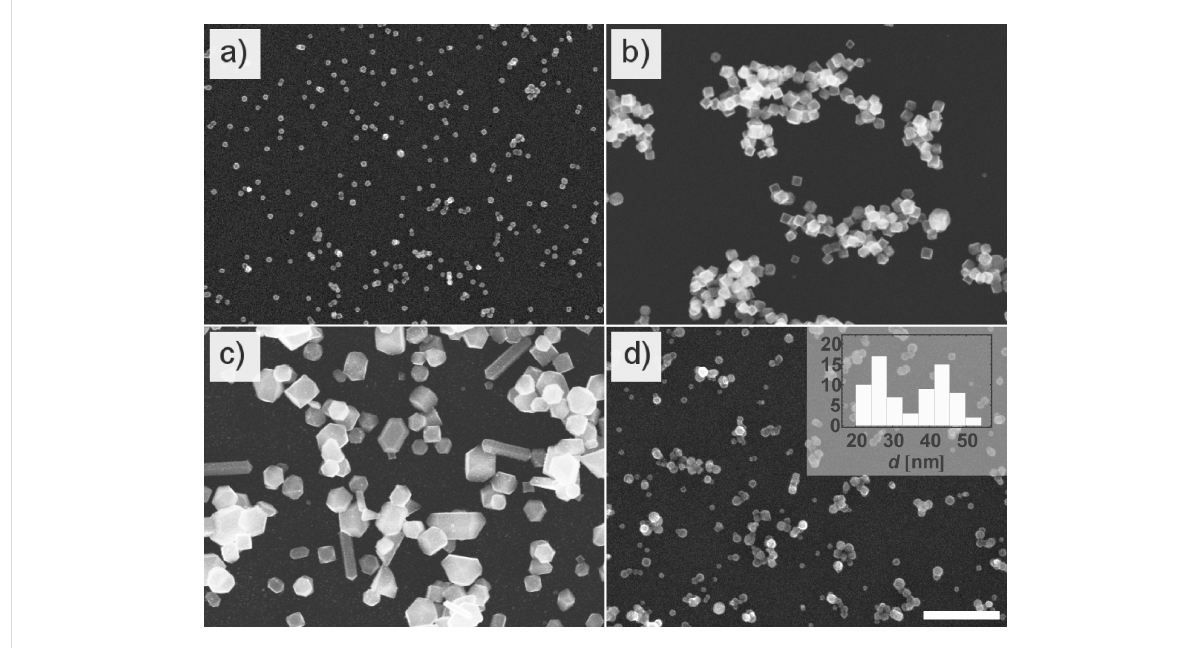
Figure 5: SEM pictures of particles generated with our plasma gas condensation setup. a) Polycrystalline Ni NPs (continuous mode), b) single crys- talline Ni NPs produced with strongly eroded target (continuous mode), c) Large sub-micron particles synthesized with strongly eroded target (inter- mittent mode), d) Ni@Cu CS particles produced by simultaneously using SG 1 and SG 2 (continuous mode). All pictures have been taken at the same magnification. The length of the scale bar is 500 nm. (lower right).